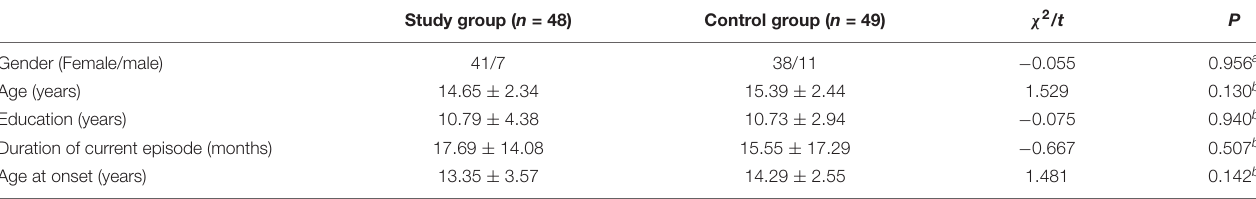
TABLE 1 | Demographic and clinical characteristics of patients.